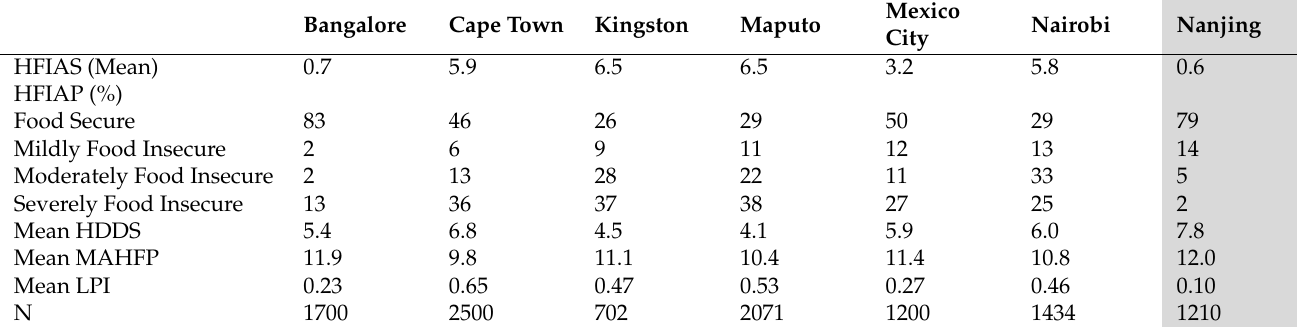
Table 2. Levels of household food security in HCP cities. (Source: Hungry Cities